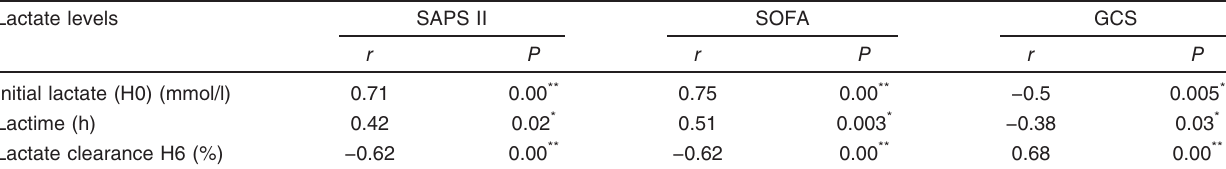
Table 4 Correlation between Simplified Acute Physiology Score II, Glasgow Coma Scale, Sequential Organ Failure Assessment, and initial lactate levels, lactime, and lactate clearance in the hyperlactatemia group Lactate levels